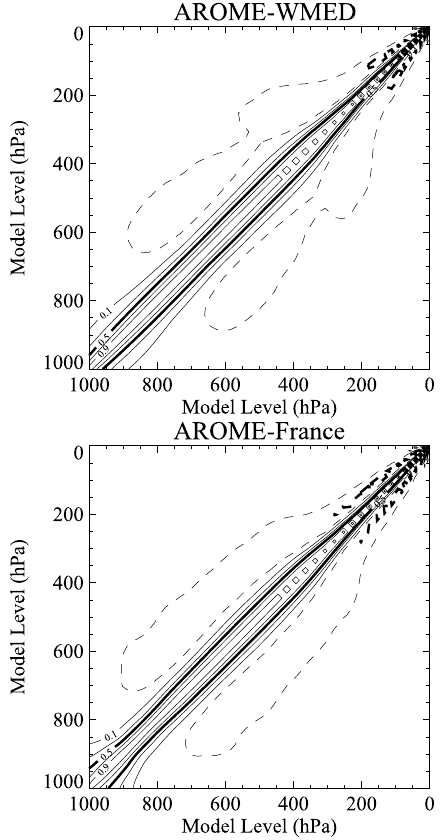
Figure 3. Vertical correlations of temperature forecast errors for AROME-WMED (top panel) and AROME-France (lower panel). Isolines plotted every 0.2 plain line: positive values, dashed line: negative values.